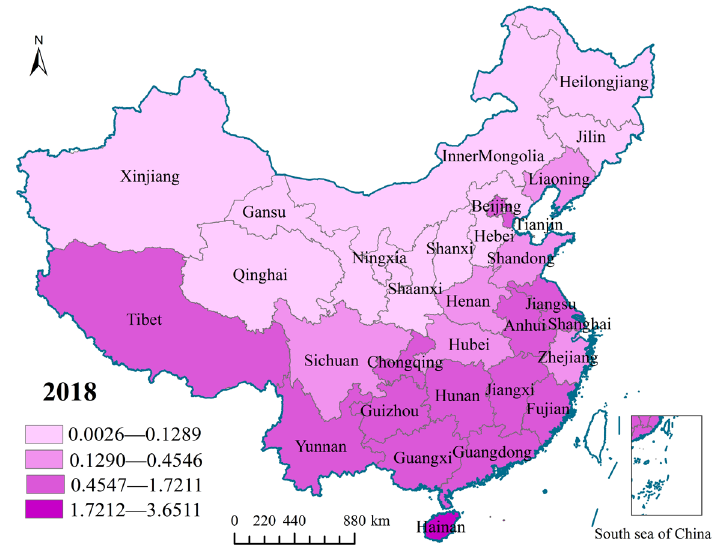
Figure 3. Distribution of forestry ecological efficiency (FEE) in China in 2018.